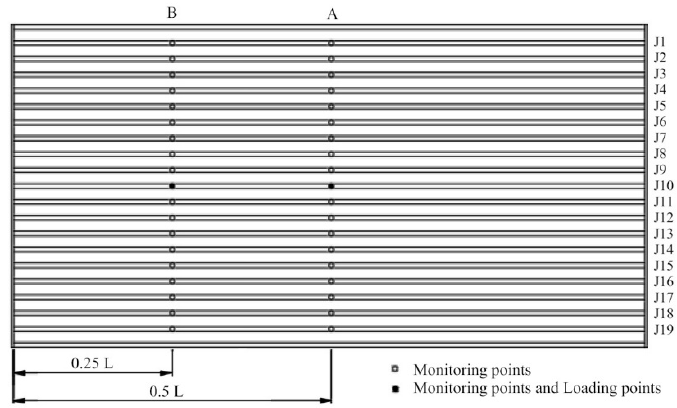
Figure 8. Distribution of the monitoring points and loading points.